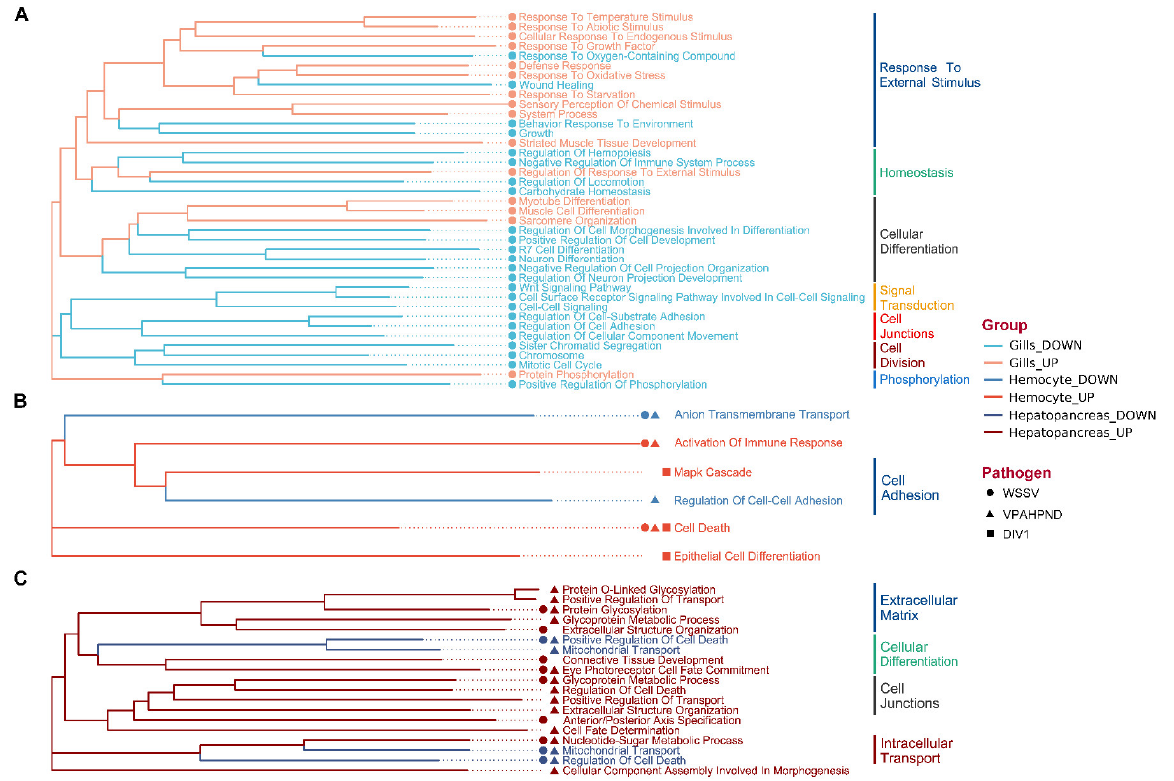
Figure 3. GO clustering diagram based on DEGs functional similarity in ( A ) gills, ( B ) hemocytes, and ( C ) hepatopancreas, constructed using the R package GOSemSim (branches that shared low functional similarity with the others were removed to reveal critical processes involved in the shrimp’s immunity). DEGs functional categories are grouped according to functional themes. The colors of the branches indicate tissue types and expressional changes (down- or up-regulated), while icons at the tip indicate the types of infection.